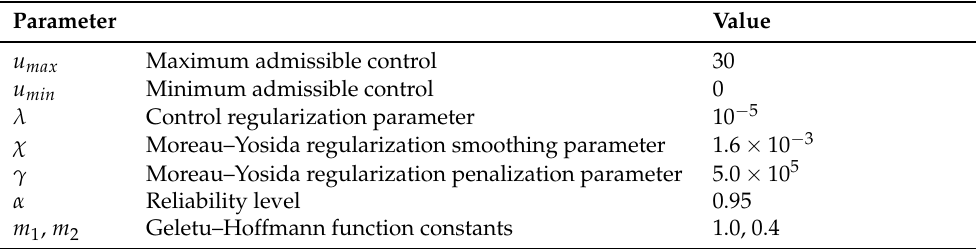
Table 2. Optimization